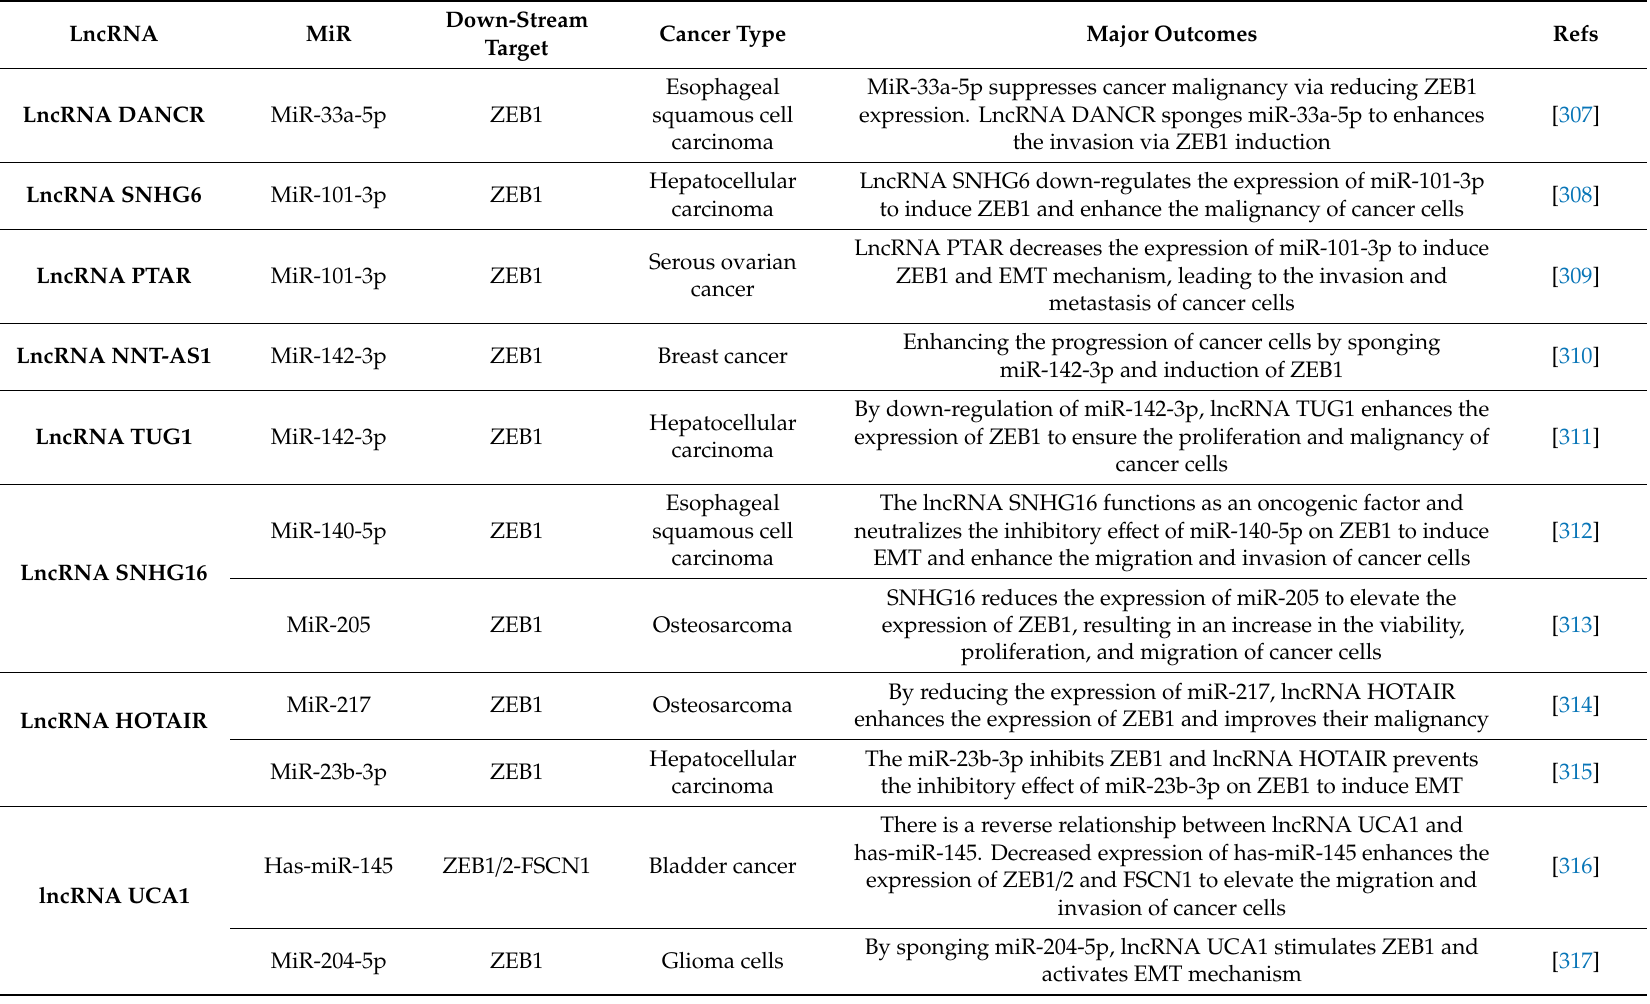
Table 2. miR / ZEB1 regulation by lncRNAs in di ff erent